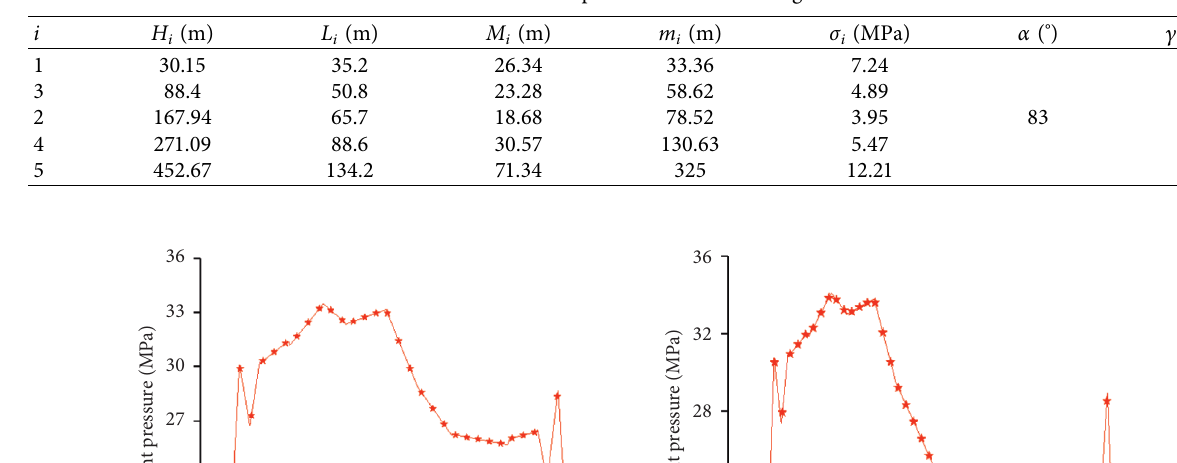
Table 2: Overburden parameters for breaking information.